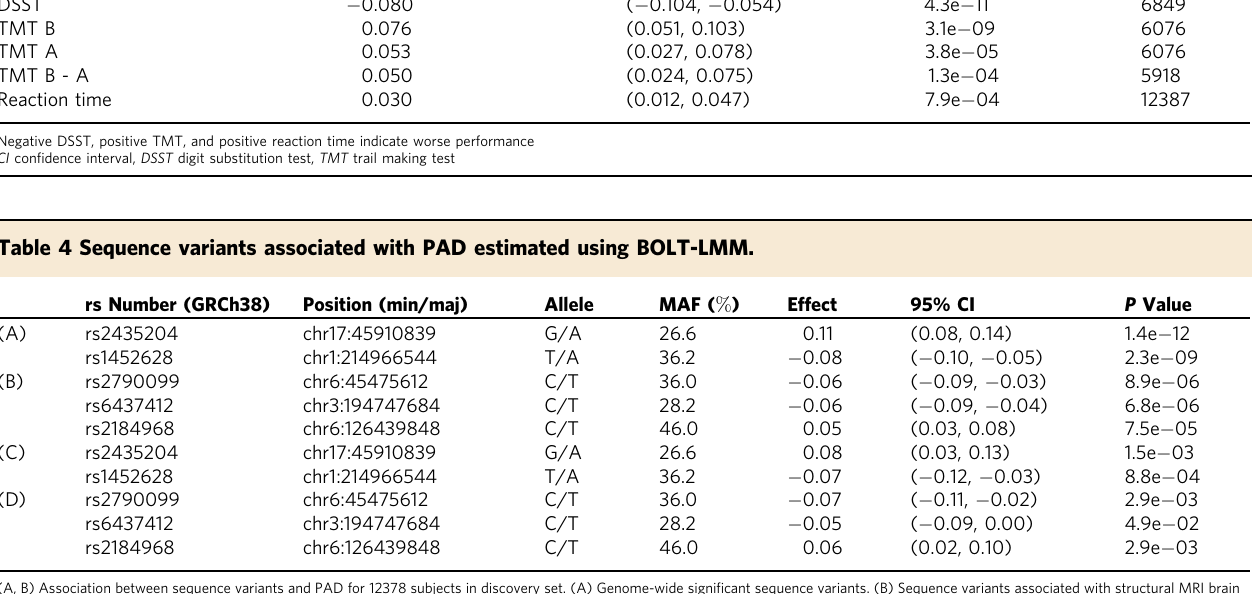
Table 3 Pearson ’ s r correlation between PAD and performance on neuropsychological tests. Neuropsychological test PAD correlation